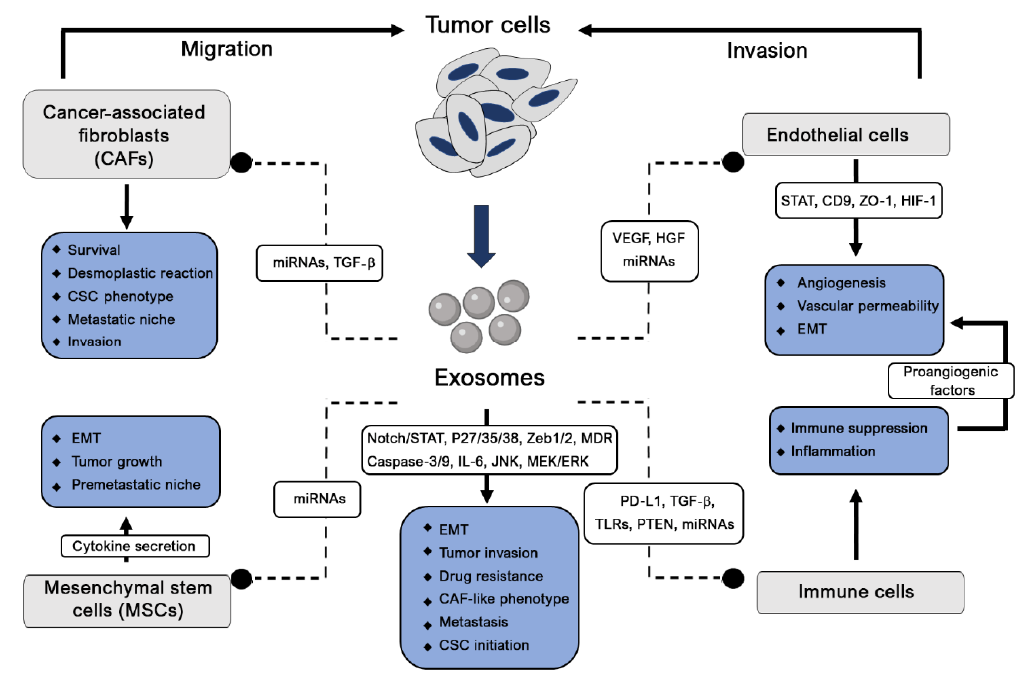
Figure 2. Roles of tumor-derived exosomes in cancer pathogenesis. Cancer stem cells: CSC. Epithelial-to-mesenchymal transition: EMT. microRNAs: miRNAs. Transforming growth factor beta: TGF- β . Signal transducer and activator of transcription: Stat. zinc finger E-box-binding homeobox: Zeb. Multidrug resistance: MDR. Interleukin 6: IL-6. Jun N-terminal kinases: JNK. Mitogen-activated protein kinase kinase: MEK. Extracellular signal-regulated kinases: ERK. Vascular endothelial growth factor: VEGF. Hepatocyte growth factor: HGF. Programmed death-ligand 1: PD-L1. Toll-like receptors: TLRs. Phosphatase and tensin homolog: PTEN. Cluster of differentiation 9: CD9. Zonula occludens-1: ZO-1. Hypoxia inducible factor-1: